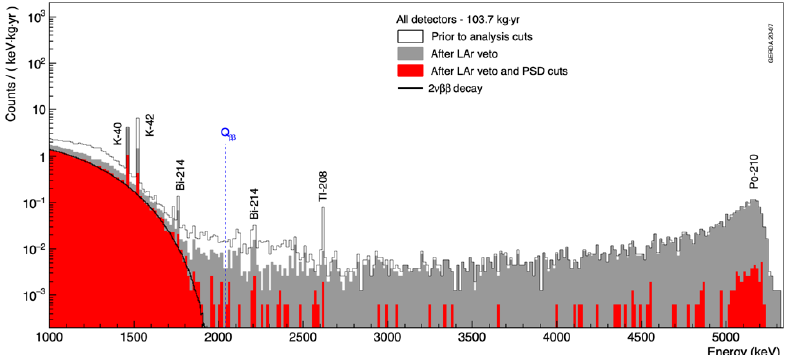
Figure 26. Energy distribution of GERDA Phase II events between 1000 and 5300 keV before and after analysis cuts. The major γ -lines and the α population at the highest energies are labeled. Prior to analysis cuts After analysis cuts Q ββ